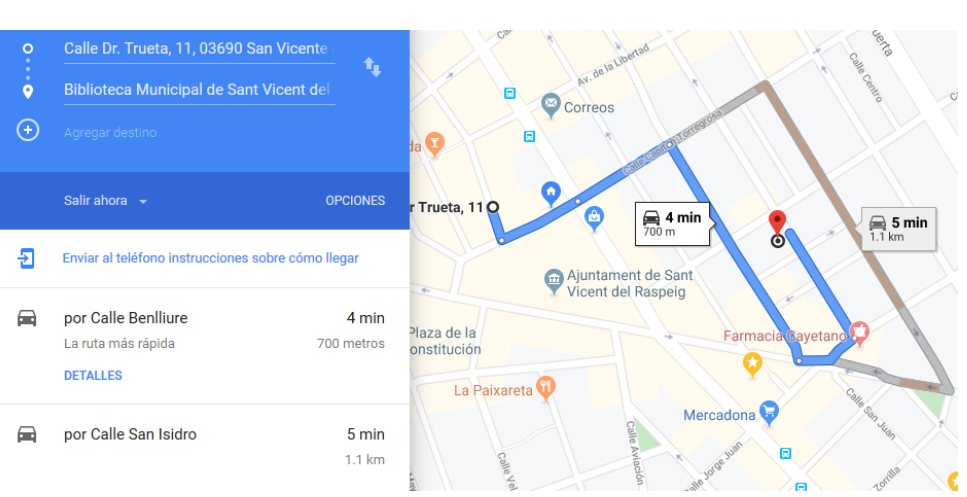
Figure 2. Routes API examples. This API returns a set of GPS coordinates on turning points and several intersections in the route. In this figure, these GPS points are marked with a white dot along the